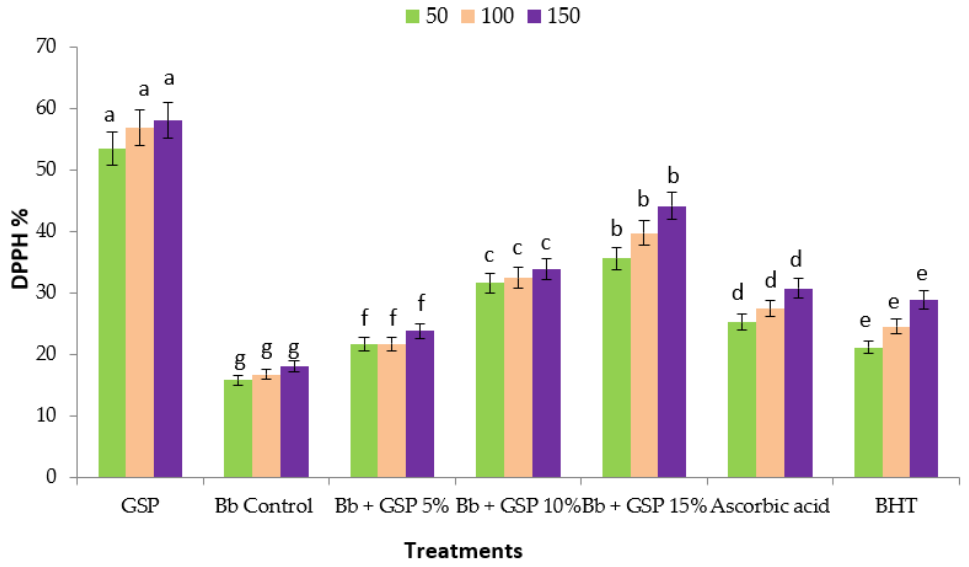
Figure 4. Antioxidants capacity % of balady bread (Bb) supplemented with different ratios of grape seed powder (GSP) extracts at different concentrations against DPPH. Each value is a mean (±SD) of three replicates. The different letters on the same bar show a significant difference according to Duncan’s test at p ≤ 0.05.